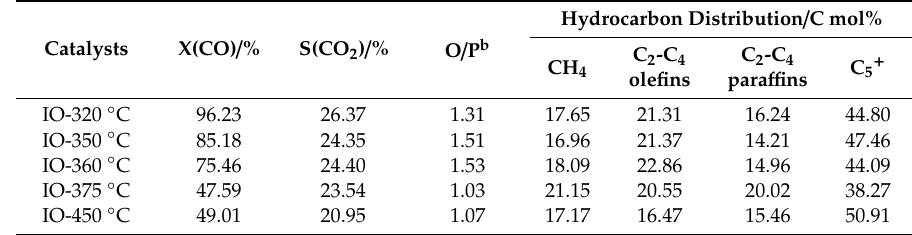
Table 2. The Fischer-Tropsch Synthesis (FTS) properties of iron oxalate carbonized at di ff erent carburization temperatures a